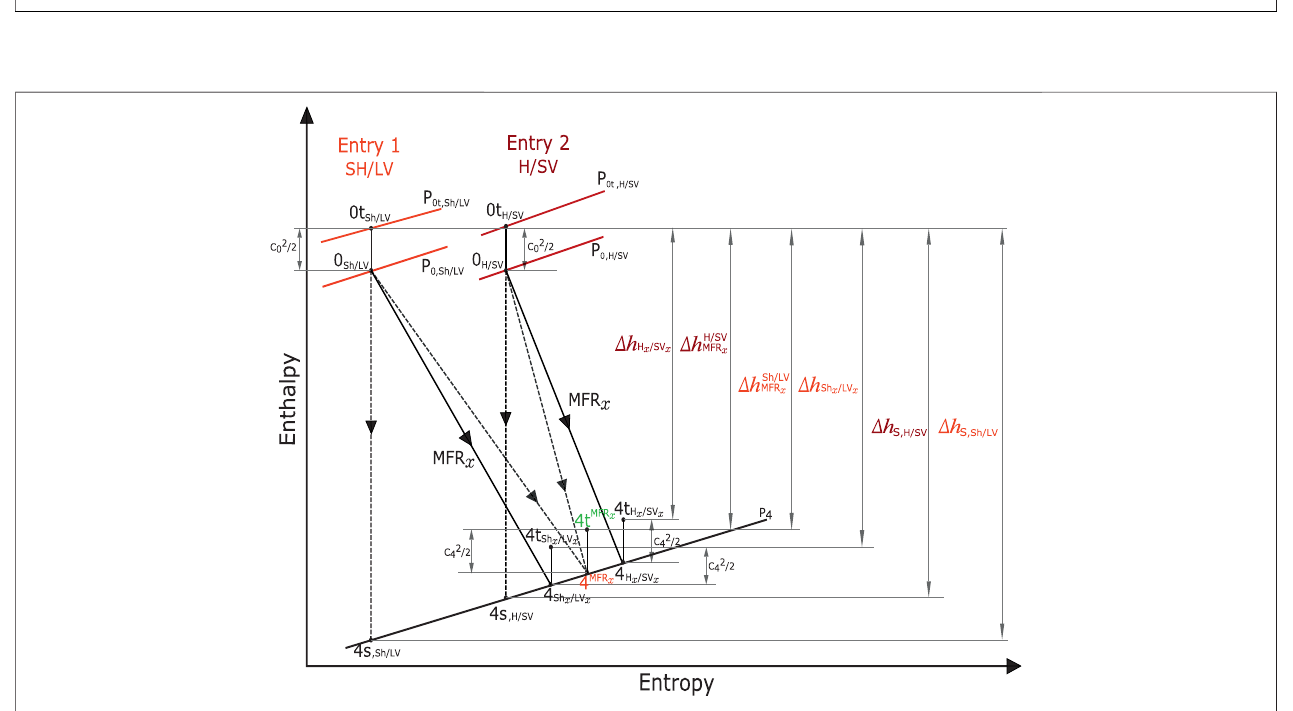
FIGURE 20 | Enthalpy-entropy expansion process in twin-entry/dual-volute radial turbines, Serrano et al. (2020b).